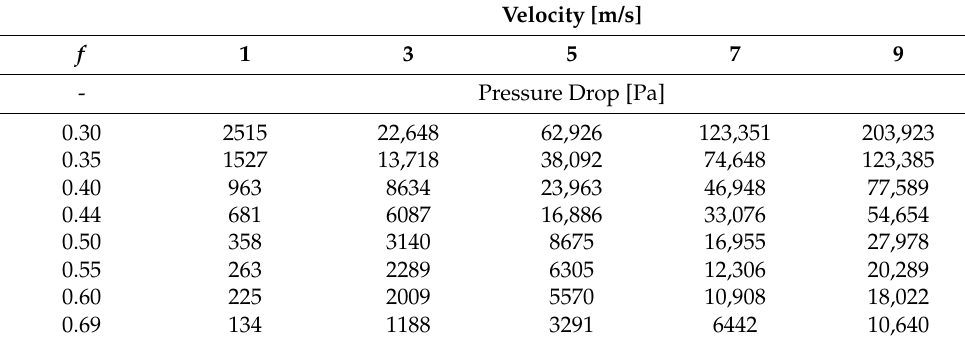
Table 4. Pressure drop for the tested plates for various